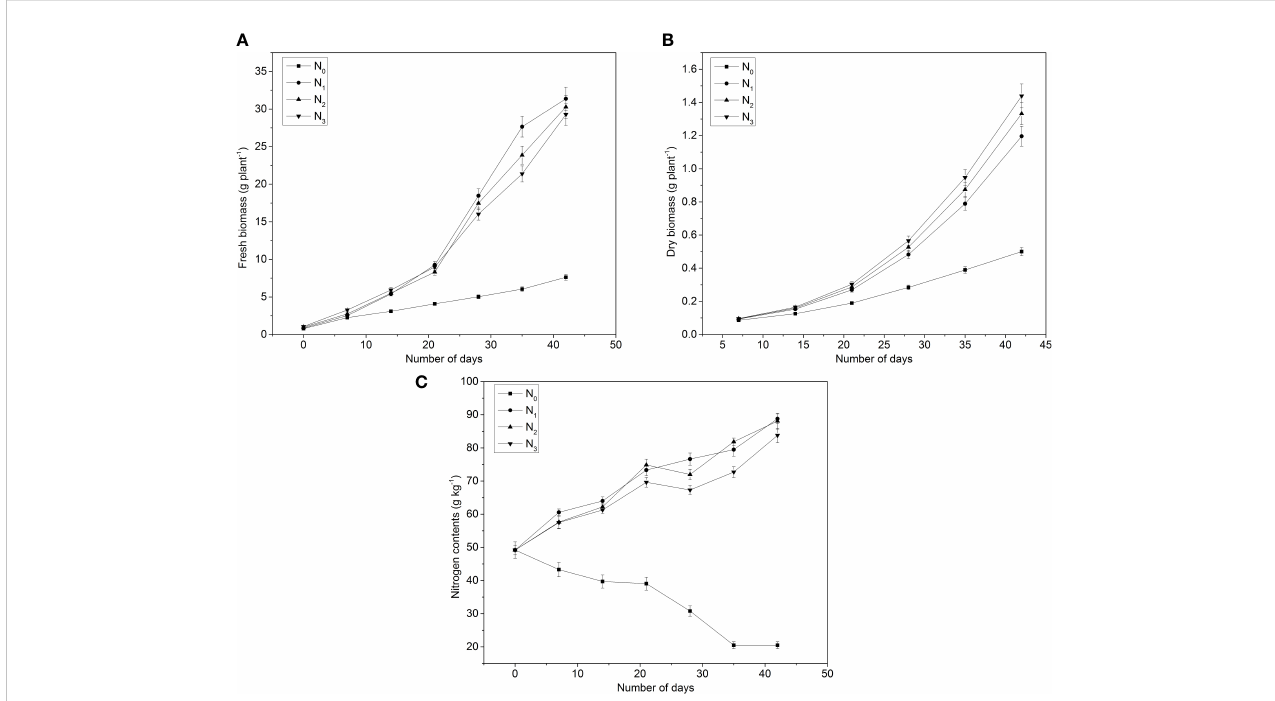
FIGURE 2 Effects of N application on (A) plant fresh biomass (FW), (B) plant DW, and (C) N contents under different intervals of time in pakchoi (Experiment 2). N 0 = 0 g N pot -1 , N 1 = 0.134 g N pot -1 , N 2 = 0.163 g N pot -1 , and N 3 = 0.191 g N pot -1 .